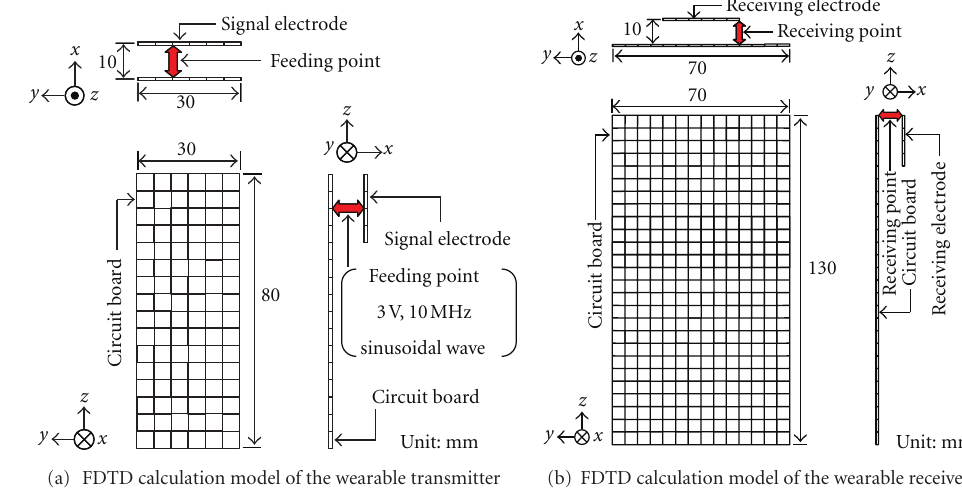
Figure 4: Structure of the wearable transmitter and receiver [8].